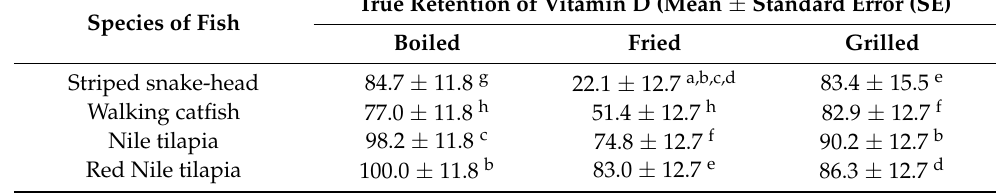
Table 6. Estimated marginal means of interaction effect of species of fish and cooking methods on true retention of vitamin D (calculated from two-way ANOVA) ( n =